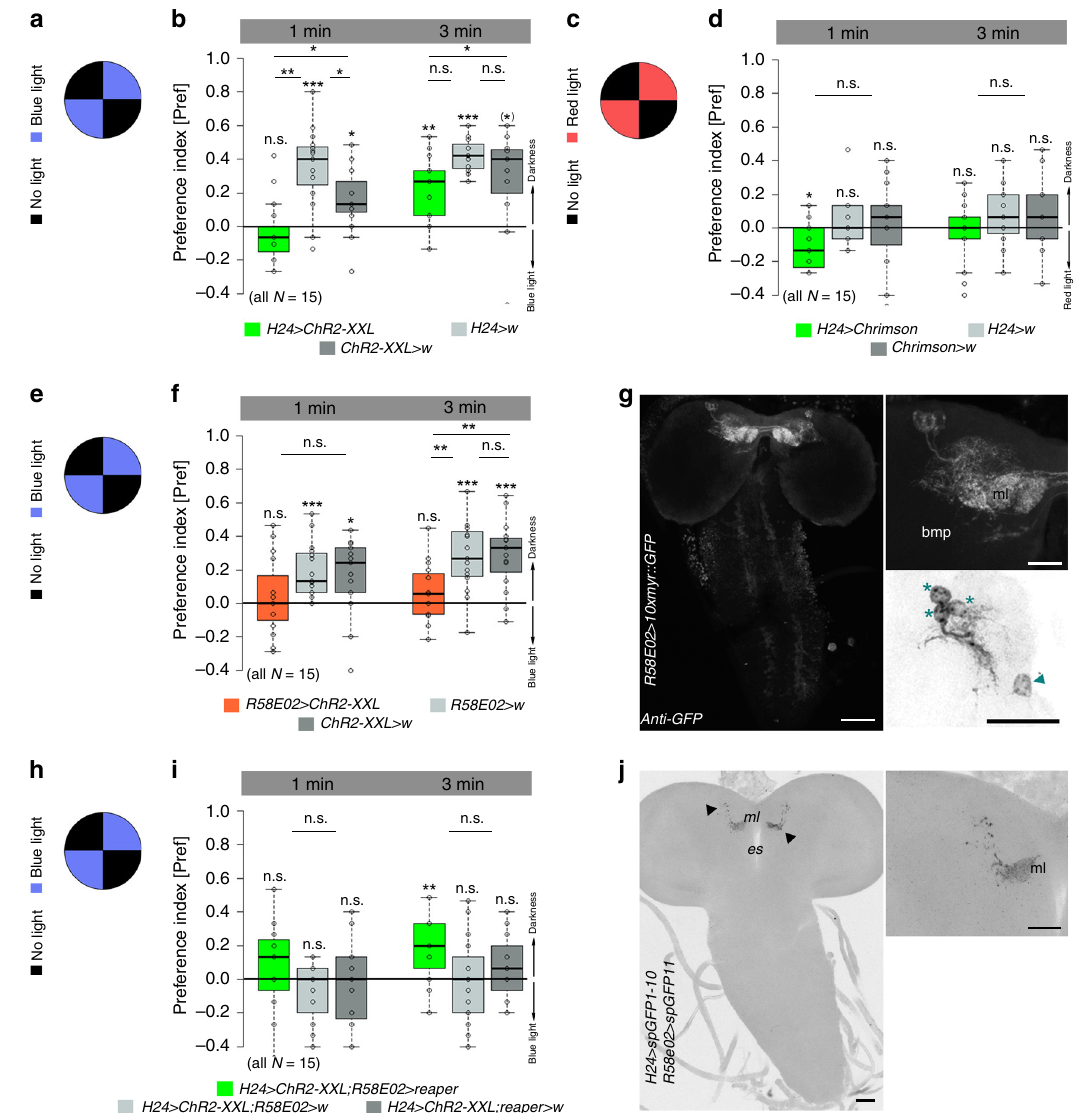
Fig. 3 Optogenetic activation of KCs induces internal reward signaling. a , b Control larvae showed blue light avoidance in a simple choice test. H24 > ChR2- XXL larvae do not show any light avoidance after 1 min, but after 3 min suggesting that the blue light-dependent activation of ChR2-XXL induces internal reward signaling. c , d In line, H24 > Chrimson larvae prefer red light over darkness after 1 min, while genetic controls were randomly distributed. e , f Optogenetic activation of pPAM neurons using R58E02-Gal4 abolished light avoidance. g Expression pattern of R58E02-Gal4 crossed with 10xUAS- myr:: GFP and stained with anti-GFP (white). Three DANs of the pPAM (protocerebral anterior medial) cluster (asterisks) and one additional cell body at the midline (arrowhead) are labeled. pPAM neurons innervate the medial lobe of the MBs. h , i Optogenetic activation of KCs abolished light avoidance in both genetic controls; in contrast experimental larvae with ablated pPAM neurons showed light avoidance after 3 min, indicating that optogenetic activation of KCs induces internal reward signaling via pPAM neurons. j Reconstituted split-GFP between H24-Gal4 positive neurons and R58E02-Gal4 positive neurons is only visible at the level of the MBs (arrowheads). bmp: basomedial protocerebrum; ChR2-XXL: channelrhodopsin2-XXL; DANs: dopaminergic neurons; es: esophagus; KCs: Kenyon cells; MBs: mushroom bodies; ml: medial lobe; 10xmyr::GFP: 10xUAS-myristoylated green- fl uorescent protein; w: w 1118 . A pairwise Student ’ s t test or pairwise Wilcoxon test (both including Bonferroni-Holm correction) was used. Signi fi cance levels: n.s. p > 0.05, * p < 0.05, ** p < 0.01, *** p < 0.001. Scale bars: 50 μ m and 25 μ m for higher magni fi cations. Data are mainly presented as box plots, with 50% of the values of a given genotype being located within the box, and whiskers represent the entire set of data. No data were excluded. Outliers are indicated as open circles. The median performance index is indicated as a thick line within the box plot